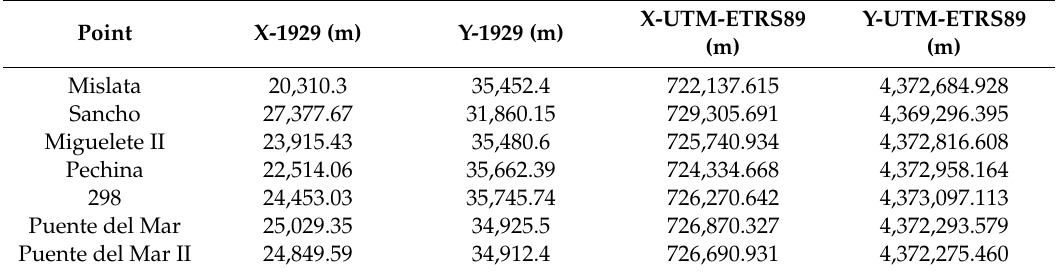
Table 5. Point coordinates in the source (1929) and target (UTM-ETRS89) reference